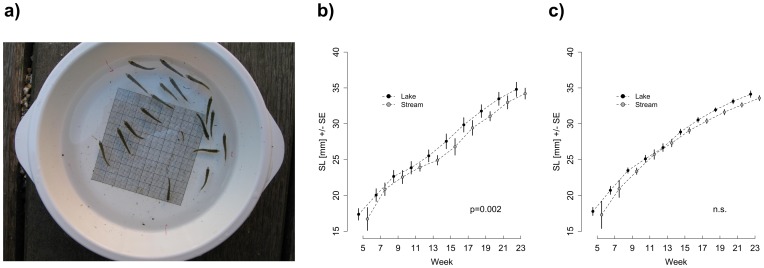
Summary of the increase in body size over time for experimental fish.(a) Illustration of the method used to estimate average family-based body size. A 1×1 mm grid was attached to the bottom of a standardized plastic container, where the water level was kept at 1.5 cm. Panels b and c show the average body size over time for lake and stream populations under either b) lake-like or c) stream-like food treatment. Dots represent the mean standard length (SL) of all families per source population (±1 SE).